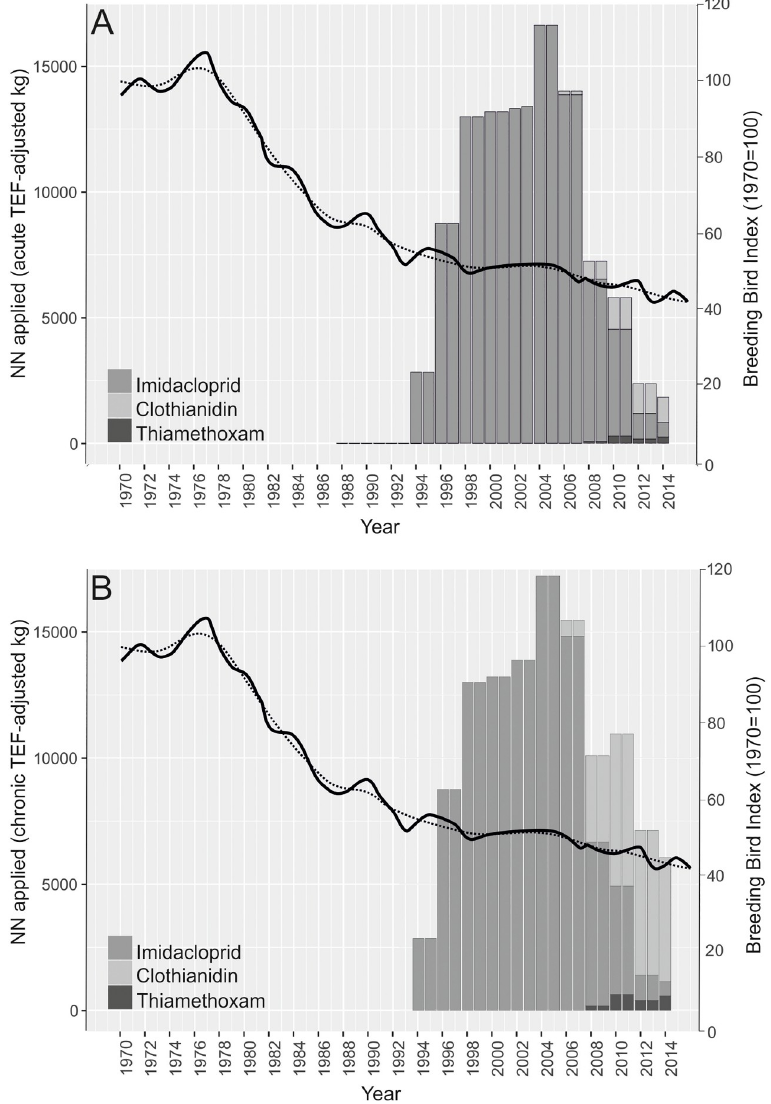
Fig 1. Change in NN application and change in farmland bird abundance for the UK between 1970 and 2014. Bars: Pesticide Usage Survey data for annual weight (kg) of NN applied, moderated by a toxicity equivalency factor (TEF) to account for differences in the acute ( Fig 1A ) or chronic ( Fig 1B ) toxicity of each NN compound to birds (see Methods for details) [9]. Lines: breeding bird index for farmland birds based on 19 farmland indicator species (solid: unsmoothed trend; dotted: smoothed trend), reproduced from the Defra report ‘Wild bird populations in the UK, 1970 to 2014: Annual statistical release’ (Fig 2) [12]. NN: neonicotinoid.